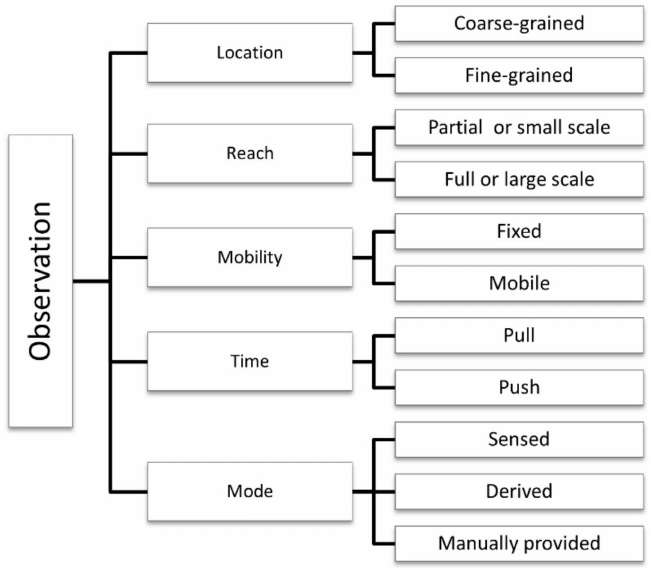
Figure 5. IoE taxonomy: observation category, its dimensions, and